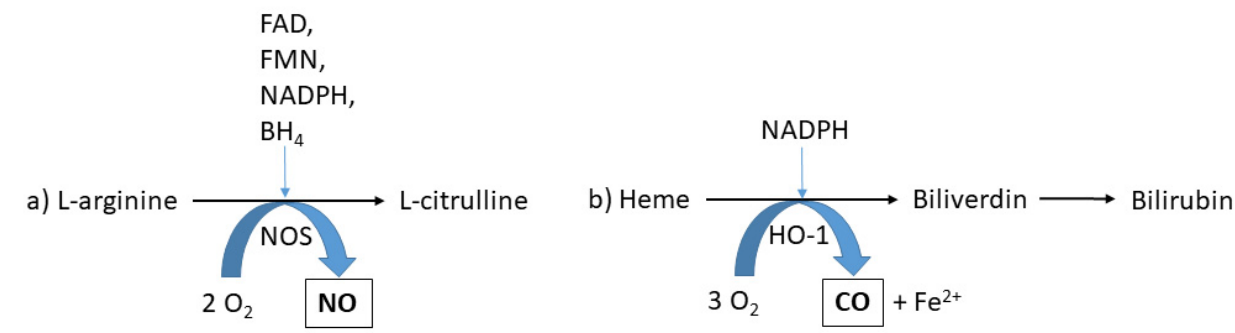
Figure 3. ( a ) Synthesis of nitric oxide (NO) from L -arginine in the presence of oxygen (O 2 ), with nitric oxide synthases (NOS) and the cofactors reduced nicotinamide adenine dinucleotide phosphate (NADPH), flavin adenine dinucleotide (FAD), flavin mononucleotide (FMN), and tetrahydrobiopterin (BH 4 ); ( b ) Heme degradation pathway: heme metabolism by heme oxygenase enzymes requires O 2 and NADPH (with NADPH CYP450 reductase) with heme oxygenase-1 (HO-1) to generate equimolar carbon monoxide (CO), iron (Fe 2+ ) and biliverdin, which is reduced to bilirubin by NAD(P)H biliverdin reductase.